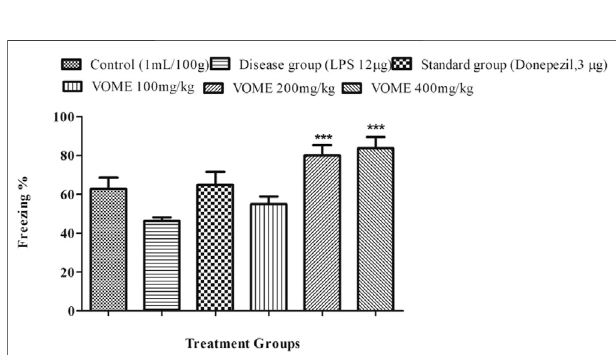
FIGURE 5 | Effect of Viola odorata methanolic extract on freezing time (%) in the fear conditioning test in mice. Data are expressed as mean ±